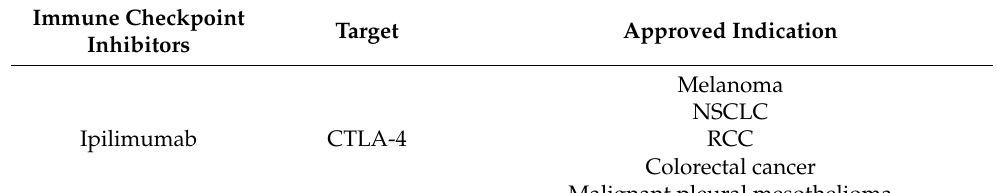
Table 1. Summary of approved immune checkpoint inhibitors (and their